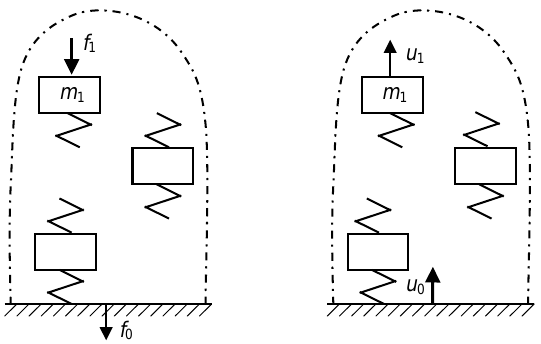
Fig. 1. Generic elastic-inertial passive isolation system. (a) Force excitation. (b) Kinematic excitation.